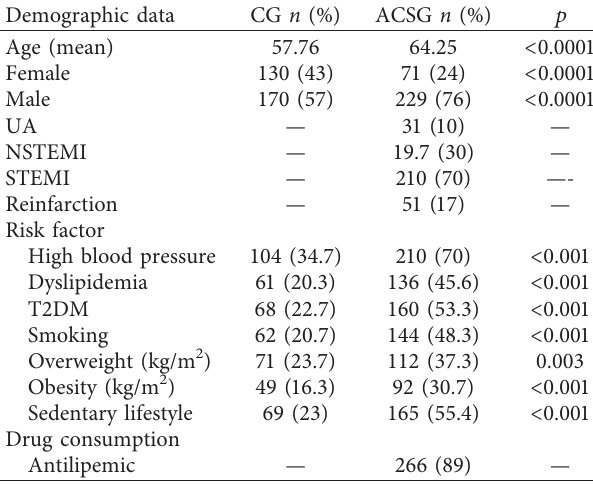
Table 1: Clinical and demographic